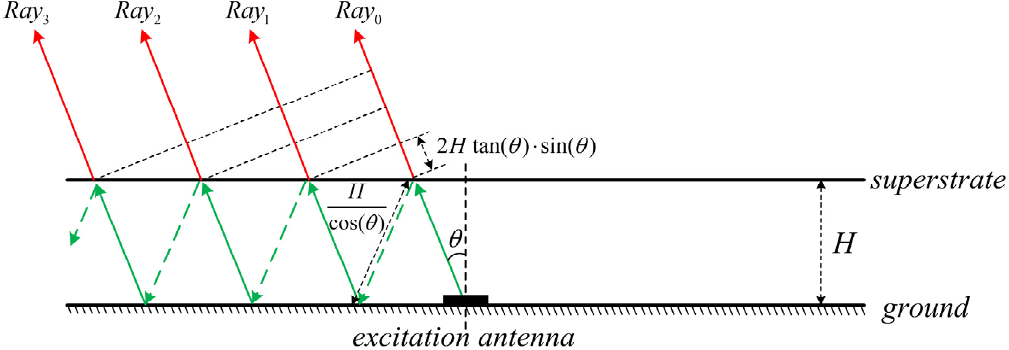
Figure 1. Schematic view of the ray tracing model for Fabry–Pérot resonator antenna.